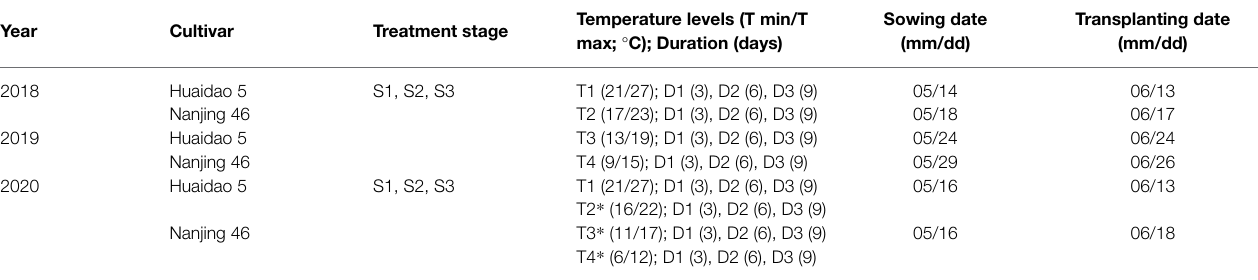
TABLE 1 | Summary of the post-heading low-temperature stress treatments.